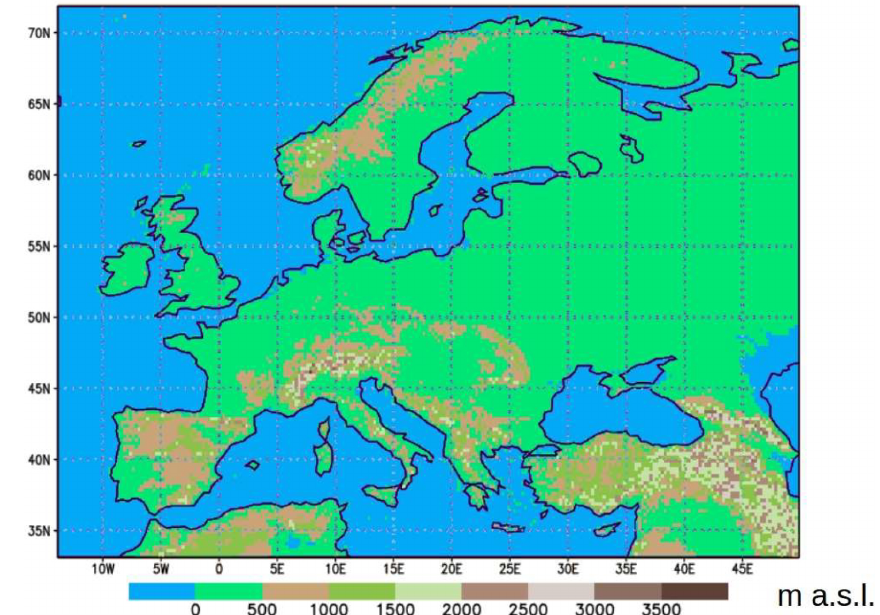
Figure 1. The topography of Europe as included in the interactive downscaling.